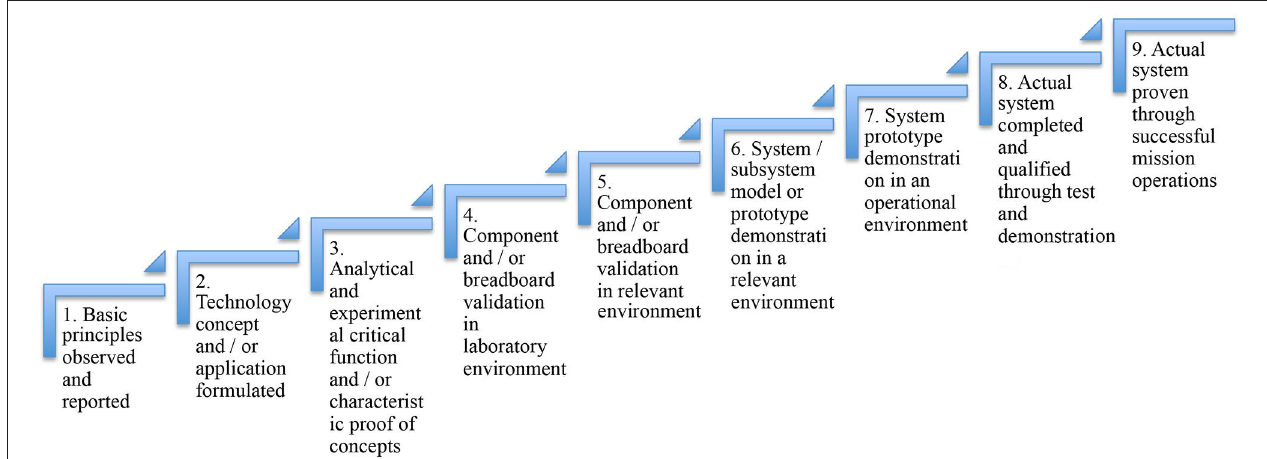
FIGURE 2 | Technology Readiness Level descriptions used by the (United States of America Department of Defense,